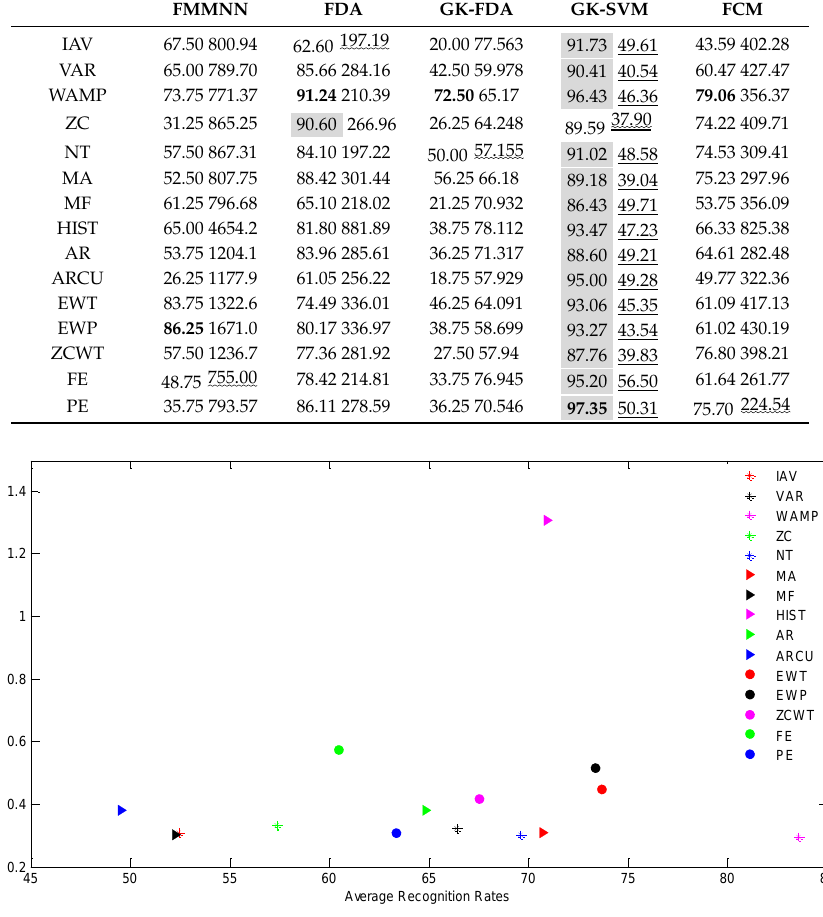
Figure 8. The average recognition accurate rates vs. the average calculation time of 15 features across the classifiers. Table 3. Recognition Rates and Calculation Time (%, ms). The bold numbers indicate the features with the highest accuracy rate for each classifier. The shaded numbers indicate the classifiers with the highest accuracy rate for each feature. The zigzag underlines indicate the features with shortest calculation time for each classifier. The straight underlines indicate the classifiers with shortest calculation time for each feature.